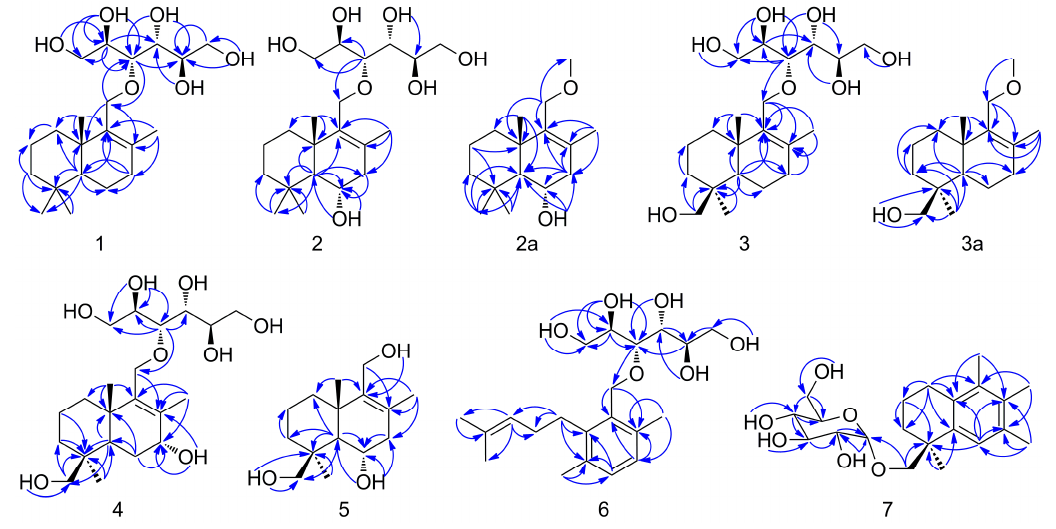
Figure 2. The key HMBC correlations for 1 – 7.